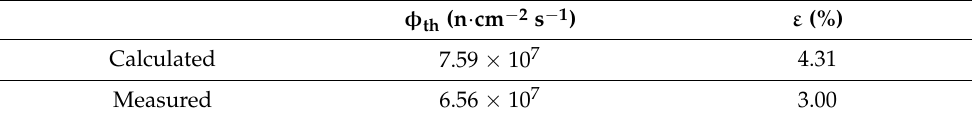
Table 1. Comparison of simulated and measured values for thermal neutron fluence